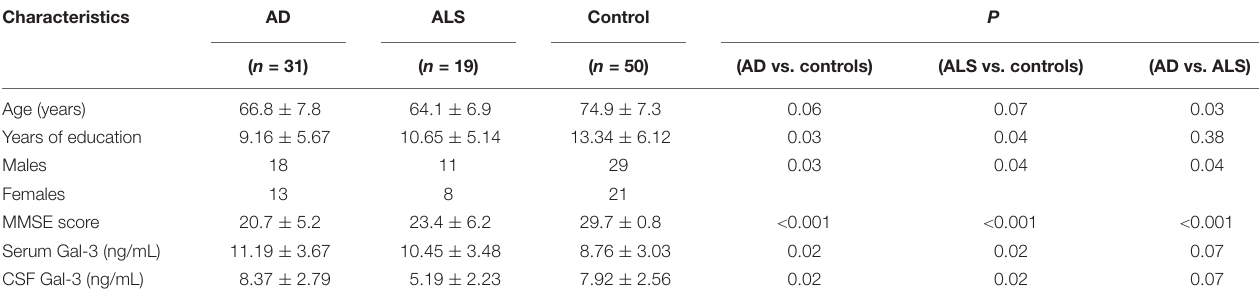
TABLE 1 | Demographic parameters and baseline characteristics. Characteristics